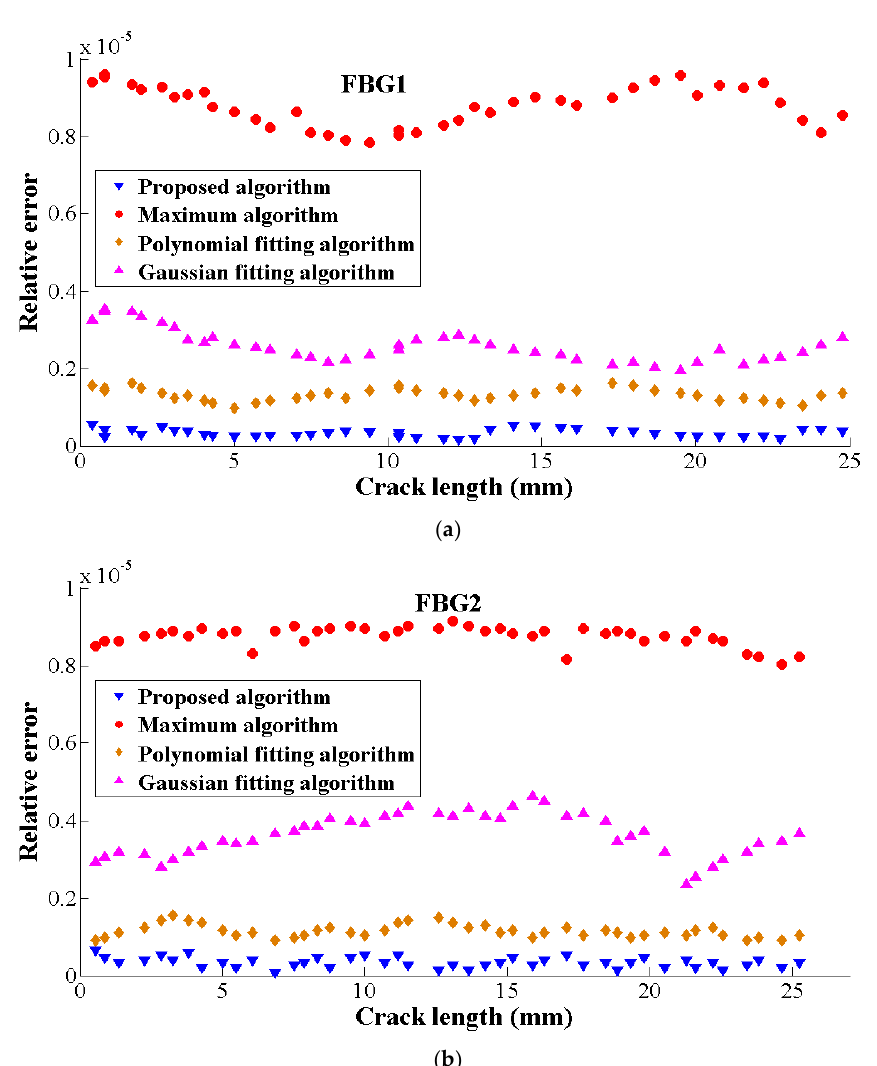
Figure 10. The absolute error of five peak seeking algorithms at different crack lengths. ( a ) The absolute error of five peak seeking algorithms in FBG1, ( b ) The absolute error of five peak seeking algorithms in FBG2.